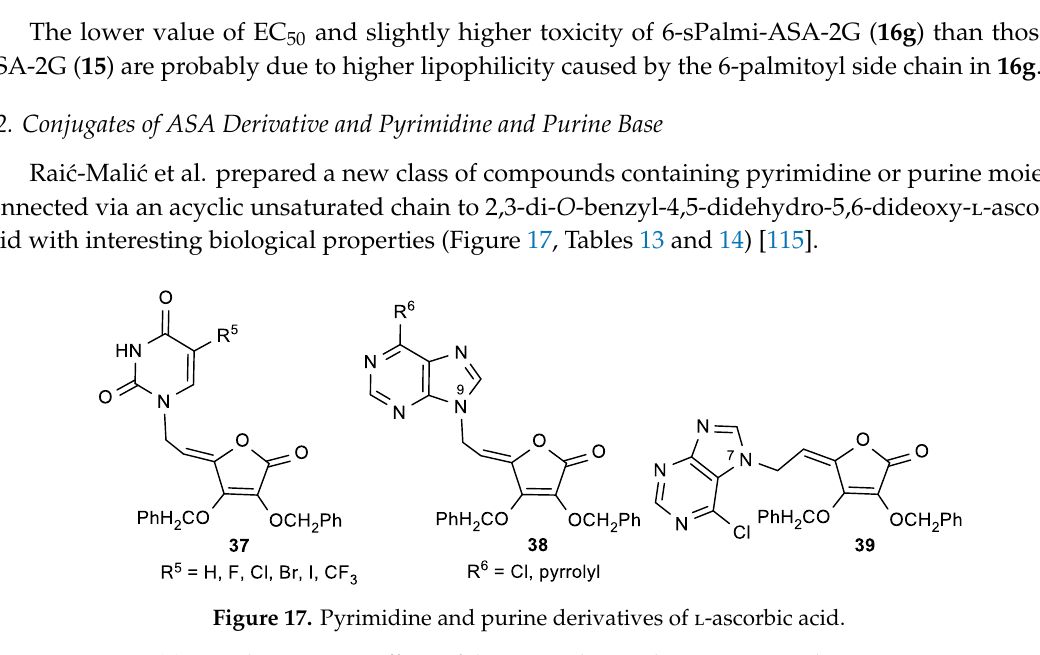
Table 12. The anti-herpes simplex virus type I (HSV-1) activity of the glucoside ASA derivatives. Comp.